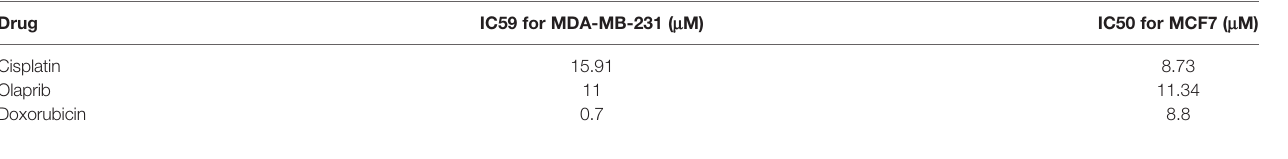
TABLE 2 | IC50 values for Cisplatin, Olaparib, and Doxorubicin in MDA-MB-231, MCF7 cells. Drug IC59 for MDA-MB-231 ( m